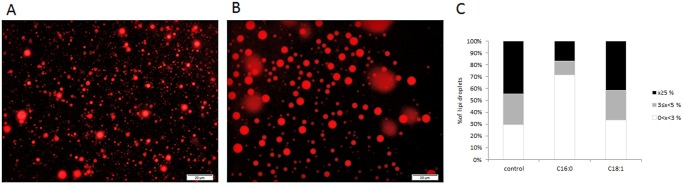
Different size distribution of lipid droplets in the medium induced by specific free fatty acids (FFAs).After cultivating mammary epithelial cells with 100 μM FFA (palmitic or oleic acid) or with FFA-free medium (control) for 24 h, medium was collected and lipid droplets were stained with Nile red. Representative images of lipid droplets in the medium collected from palmitate and oleate treatments (A and B, respectively). Droplets were measured and divided into three size groups: 0 > X < 3, 3 > X < 5, and ≤5 μm. Size distribution of lipid droplets in the medium was compared by chi-square test (C). Scale bar = 20 μm.